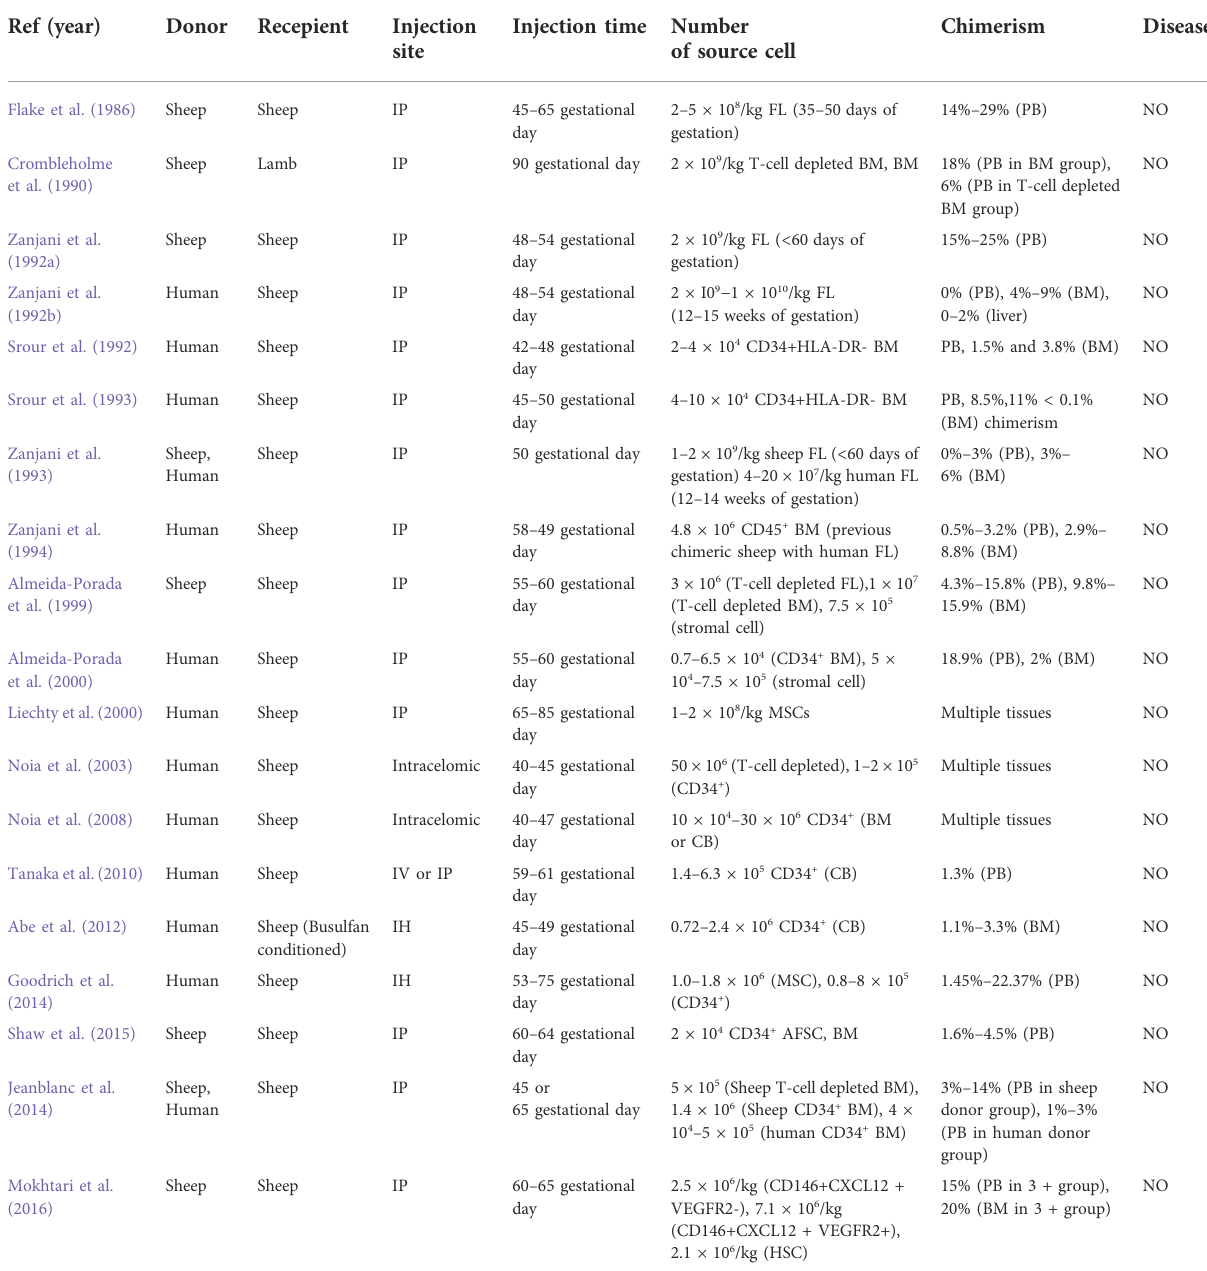
TABLE 2 IUT in ovine